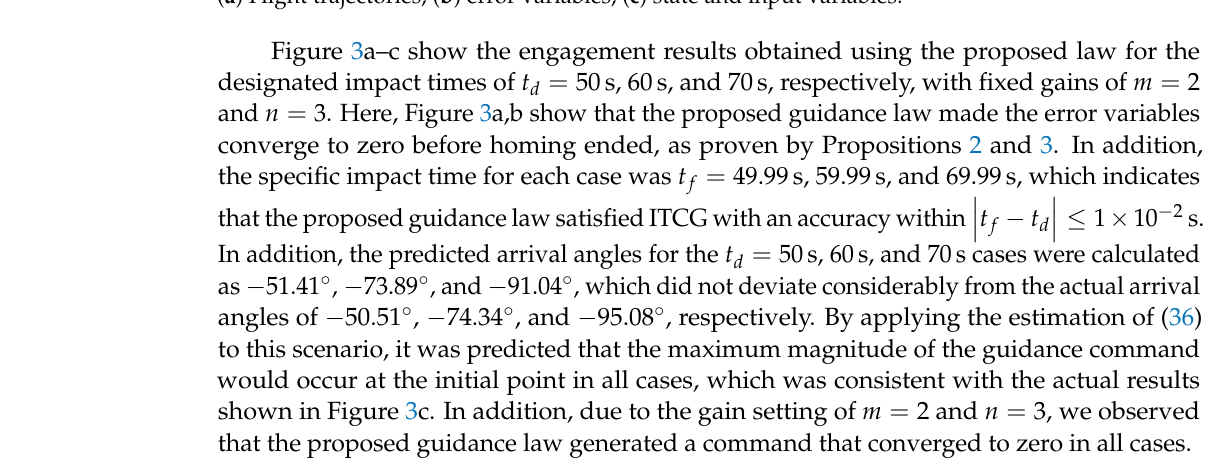
Figure 2. Simulation results under the proposed law with gains of ( m , n ) = ( 0,1 ) , ( 1,2 ) , and ( 2,3 ) . ( a ) Flight trajectories; ( b ) error variables; ( c ) state and input variables.